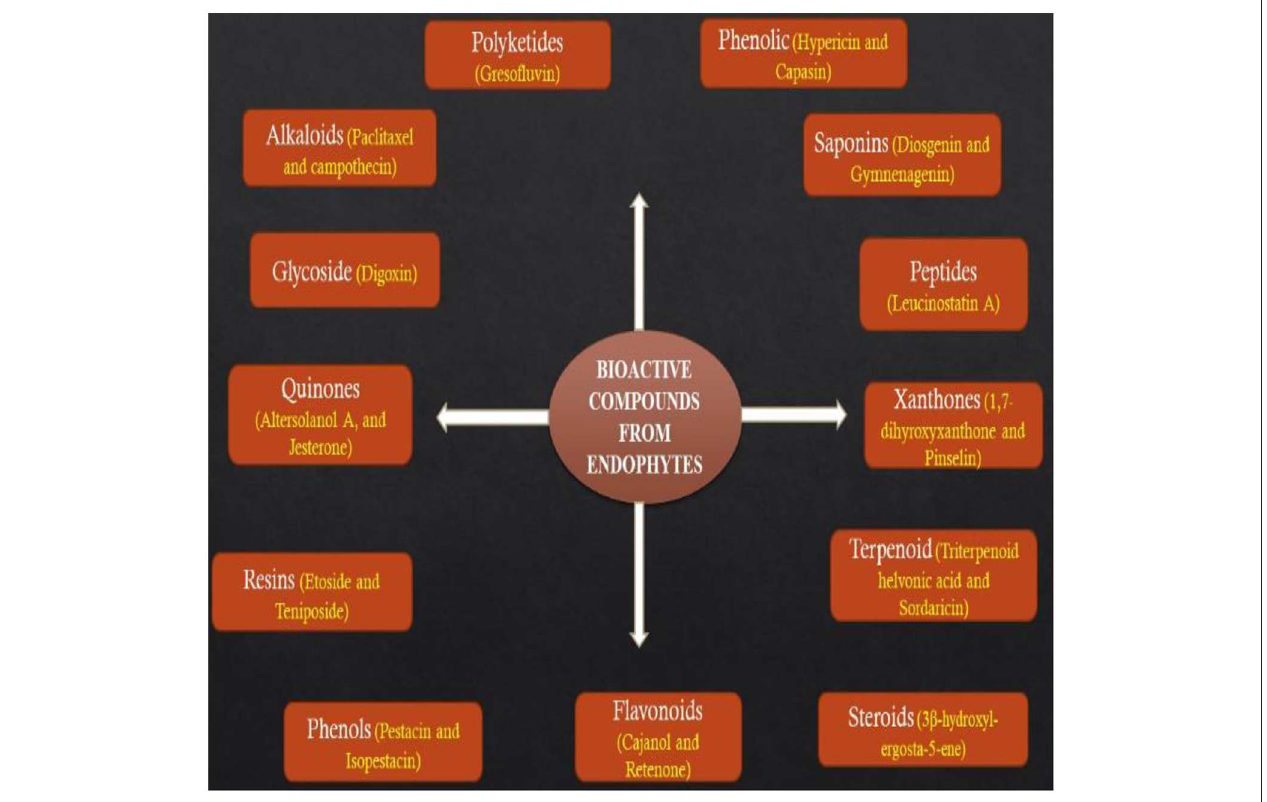
FIGURE 2 | Bioactive compounds produced by